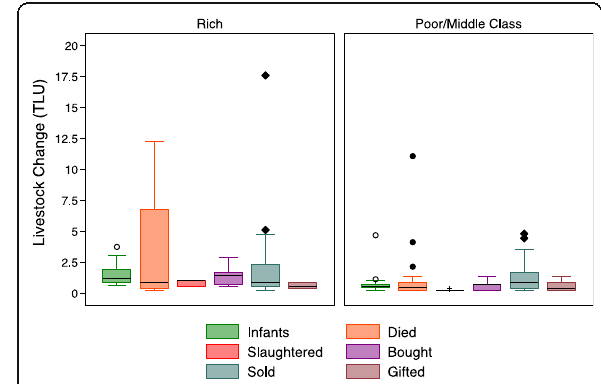
Figure 19 Absolute change in livestock numbers from 2008 to 2010 among 19 households in the Ilmotiok and Tiamamut group ranches. Two primary factors explain these changes in livestock numbers after the drought of 2009: death due to forage loss/disease and transfer/sale by owners